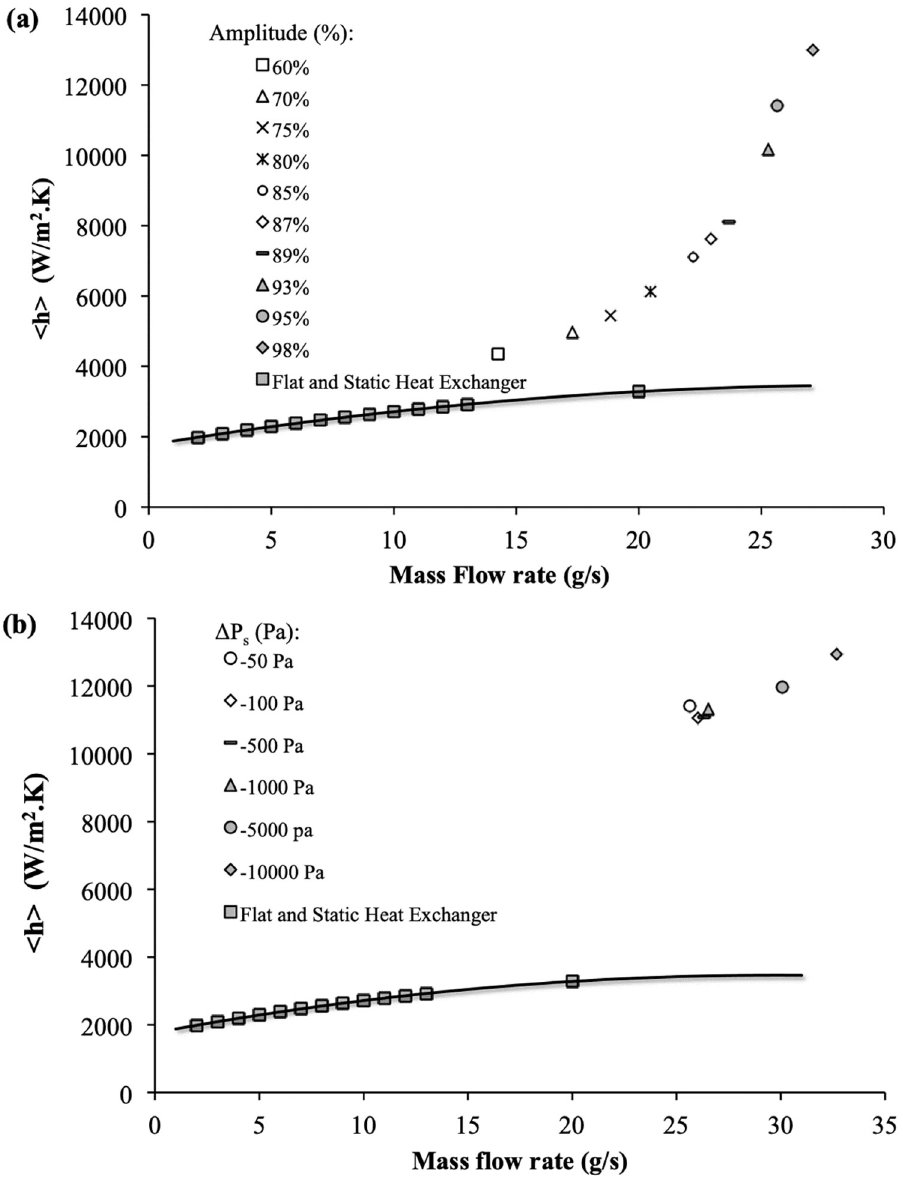
Fig 7. Global heat transfer coefficient. < h > as a function of mass flow rate for (a) different relative amplitudes and Δ P s = − 50 Pa , and for (b) different Δ P s for a relative amplitude of 95% for the dynamic corrugated channel. f r = 50 Hz . Comparison with flat and static channel is also